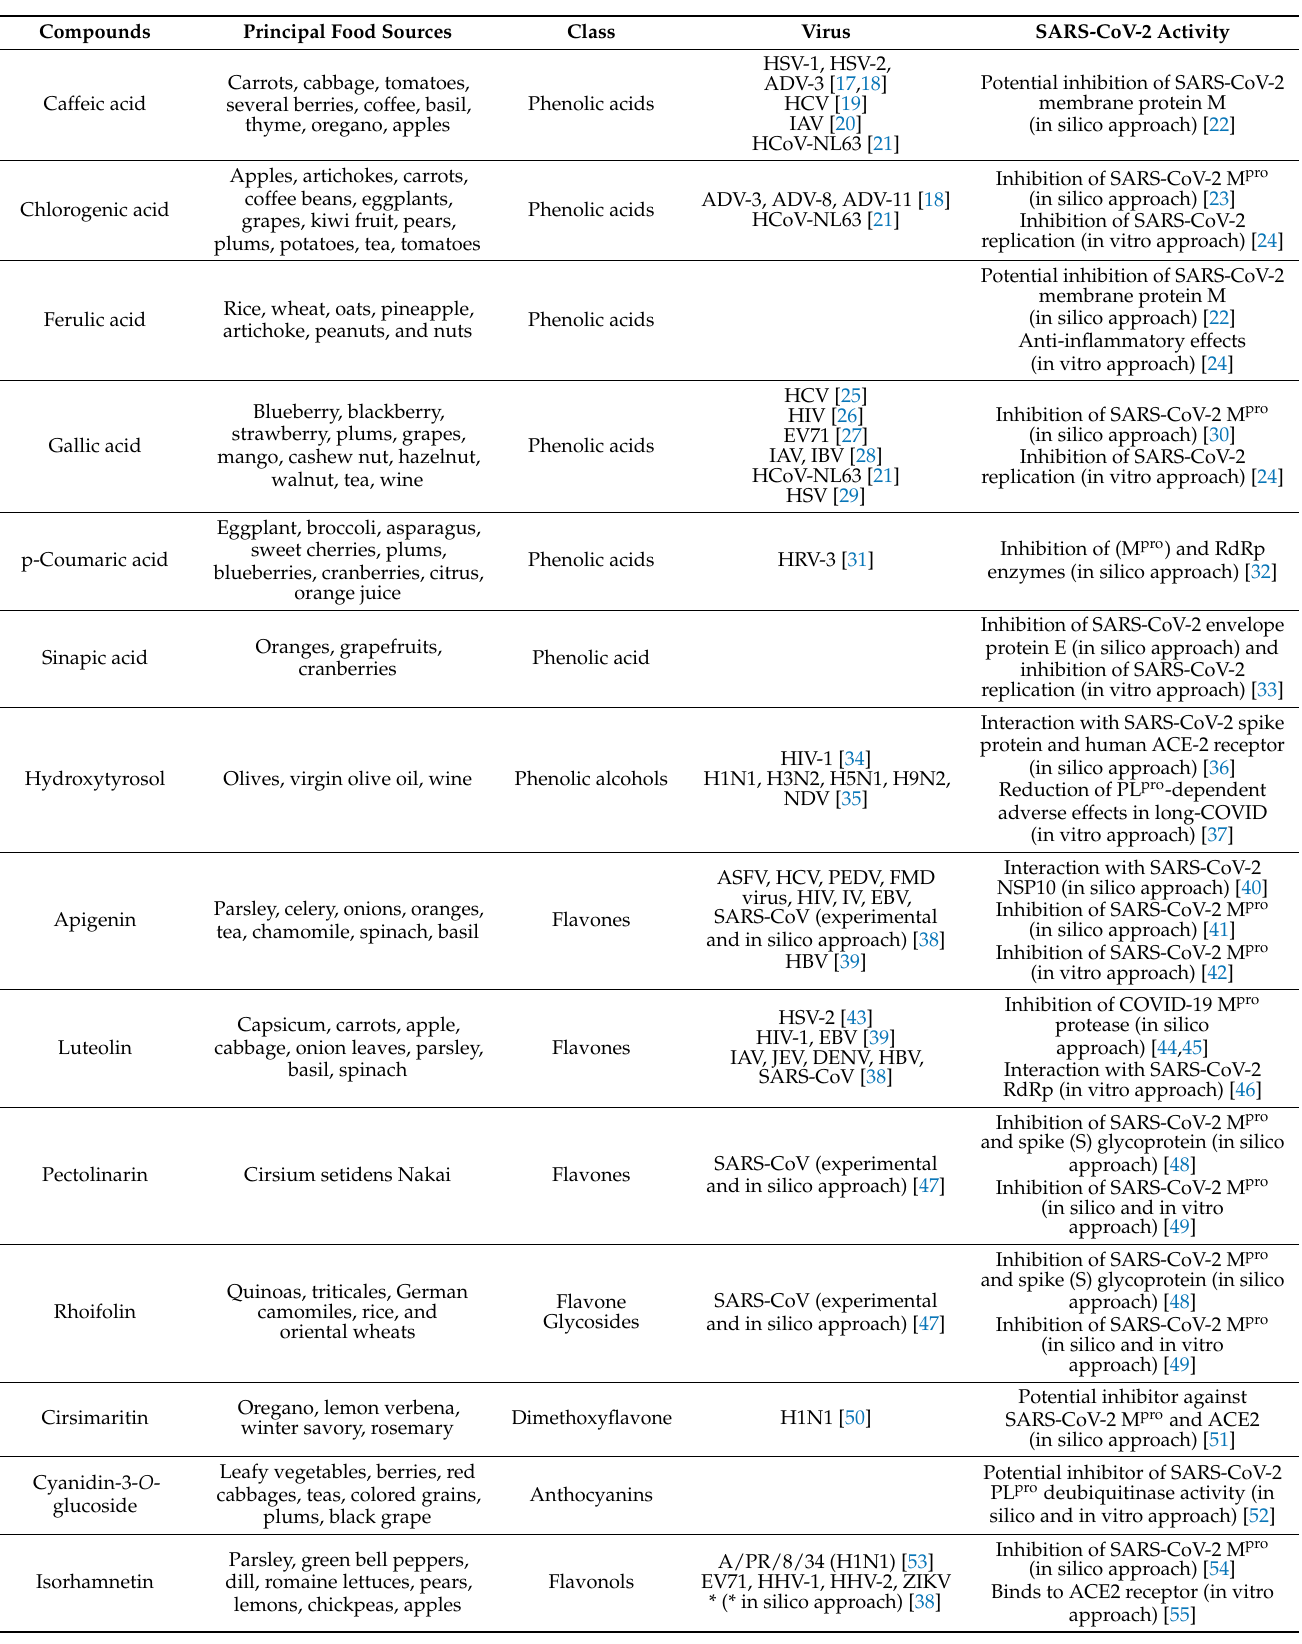
Table 1. List of selected compounds and their anti-viral properties against various viruses and/or